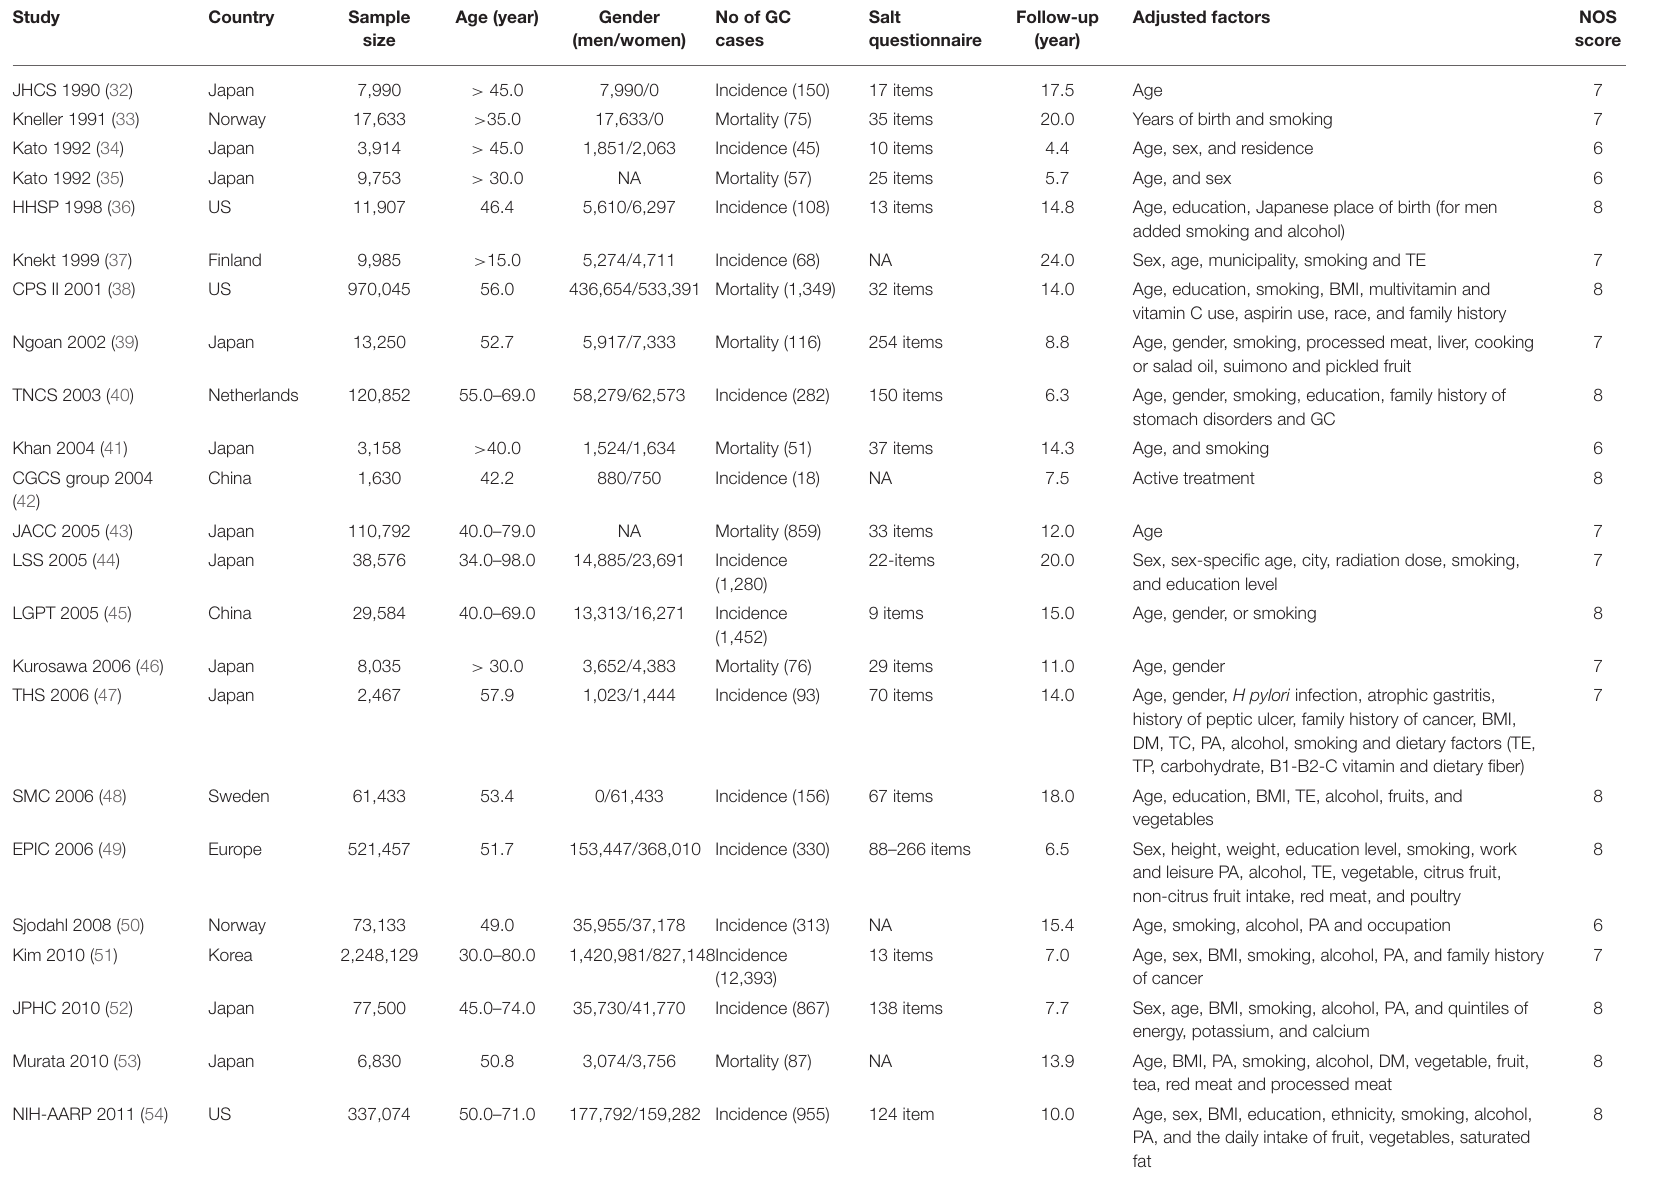
TABLE 1 | Baseline characteristic of studies included in